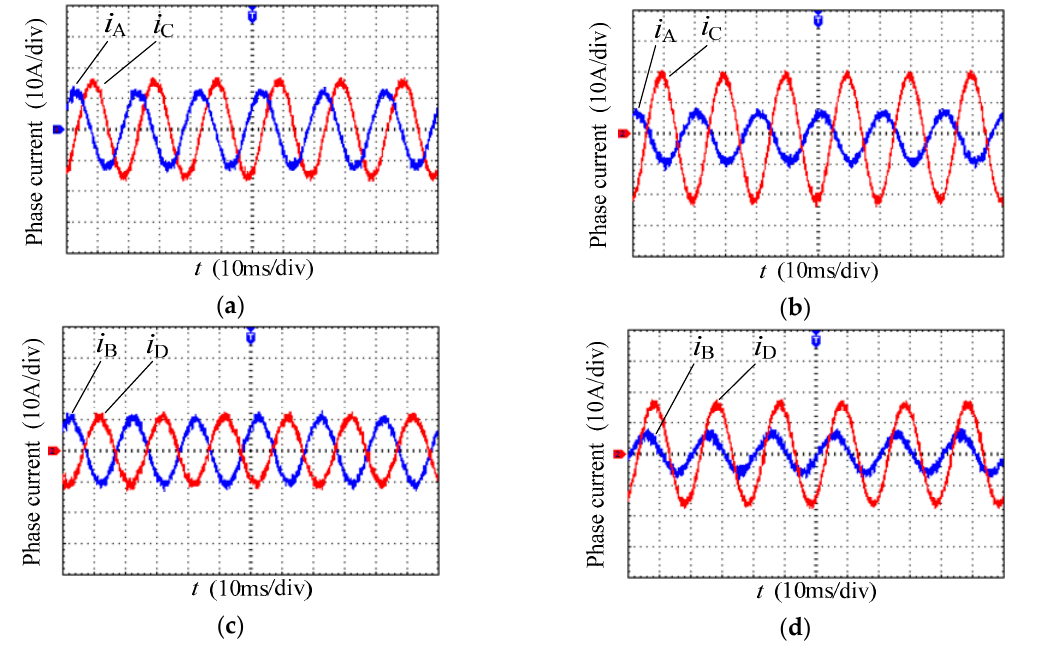
Figure 16. Stator winding currents in experiments 1 and 2. ( a ) AC-winding currents in experiment 1; ( b ) AC-winding currents in experiment 2; ( c ) BD-winding currents in experiment 1; ( d ) BD-winding currents in experiment 2.